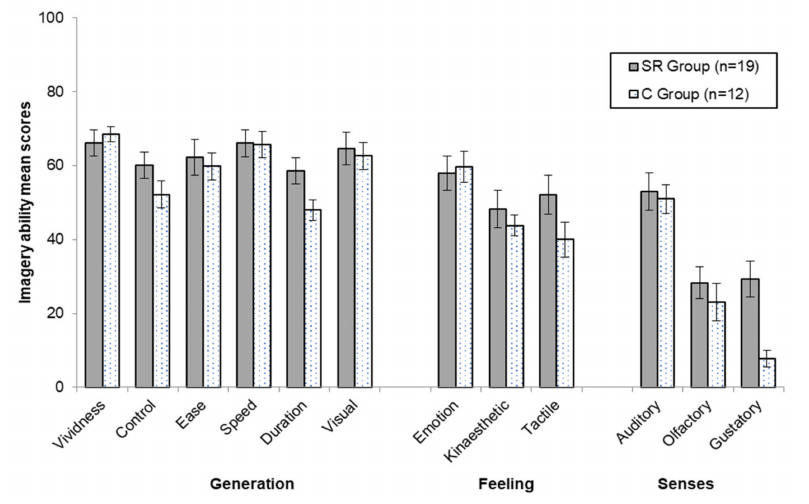
Figure 2. Mean and standard deviations of ice hockey players’ imagery ability subscale scores at phase